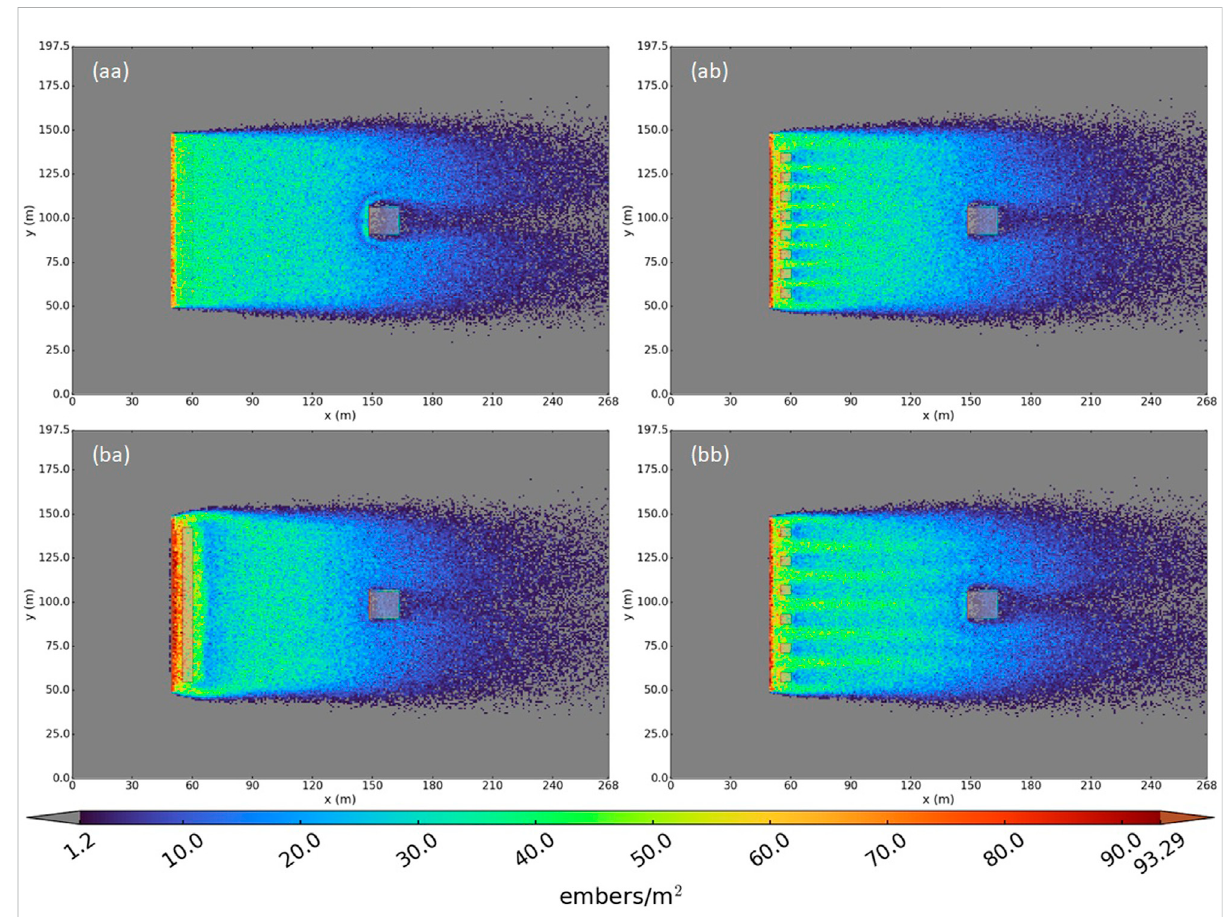
FIGURE 12 Firebranddepositionfor1Wand2Wgapvegetationspacing. (aa) 1Wgapwithoutthefence. (ab,bb) 1Wand2Wgapswiththefence,respectively. (ba) Repeat of Figure 6eb for easier comparison showing that the base case results for 1W and 2W gaps without a fence are the